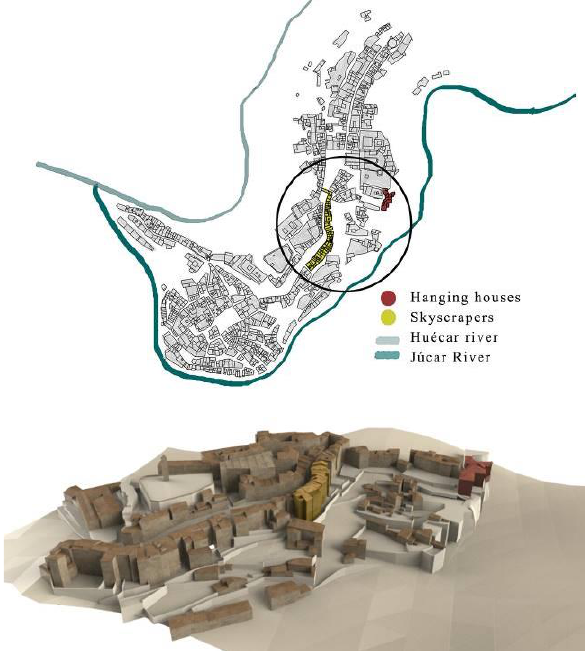
Figure 5. Location of the most representative vernacular